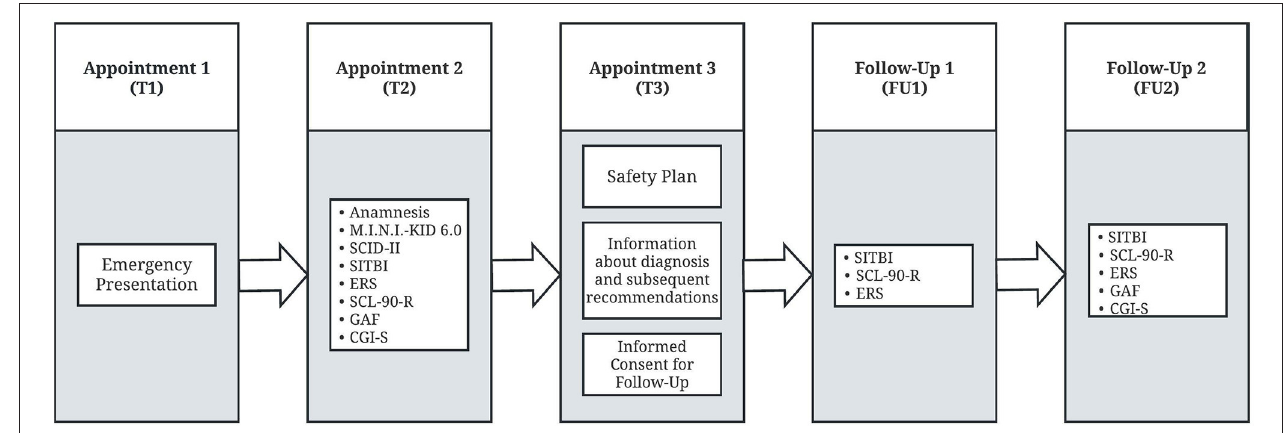
FIGURE 1 | Schematic representation of the psychiatric emergency service, short-term intervention process and follow-up examinations. T1, emergency presentation due to self-injurious thoughts and behaviors; T2, standardized emergency management; T3, short-term intervention via safety plan, subsequent recommendations and informed consent for follow-up; FU1 and FU2: follow-up examinations 4 (FU1) and 8 weeks (FU2) after T3 for evaluation of the effectiveness of the standardized emergency assessment; Mini-International Neuropsychiatric Interview for Children and Adolescents (M.I.N.I. KID 6.0), Structured Clinical Interview for DSM-IV, Axis II (SCID-II), the Self-Injurious Thoughts and Behaviors Interview (SITBI), Emotion Reactivity Scale (ERS), Symptom Checklist-90 Revised (SCL-90-R), Global Assessment of Functioning Scale (GAF), Clinical Global Impressions Scale